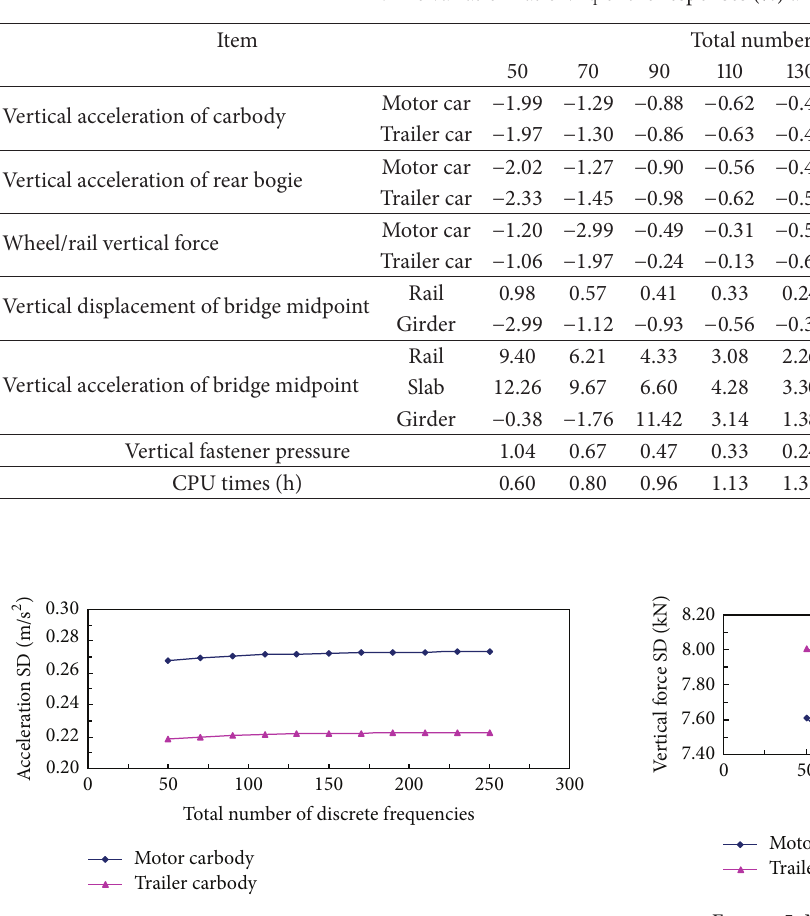
Table 4: The variation ratio VR